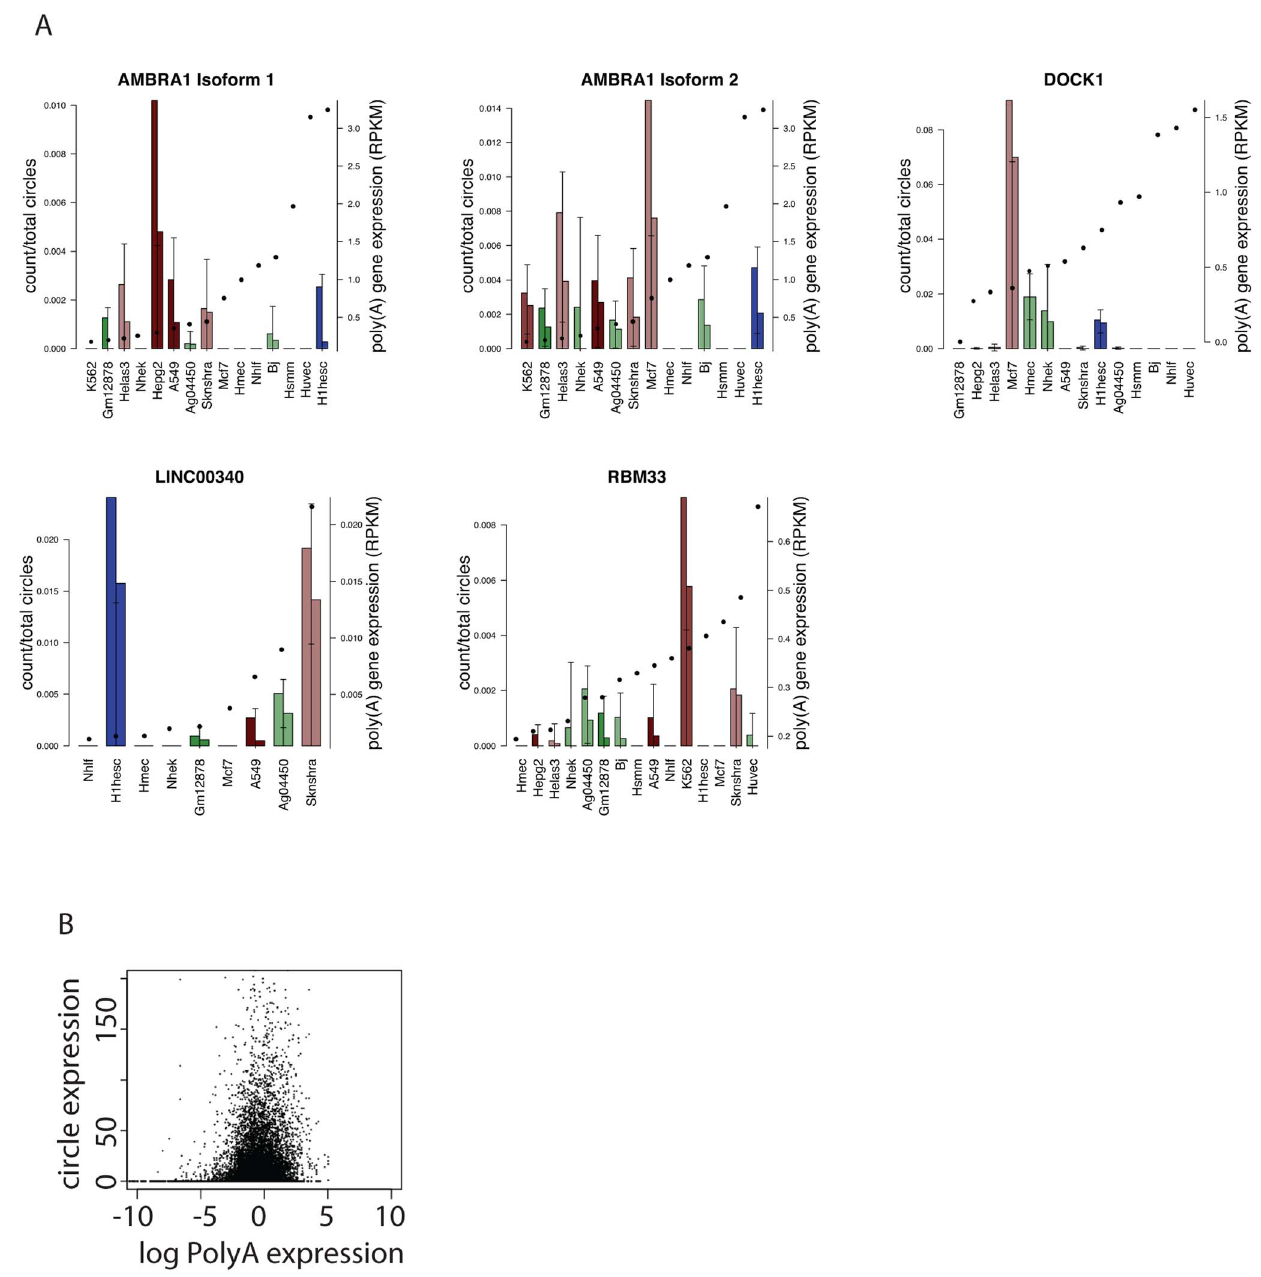
Figure 6. Quantitative regulation of circular to linear isoform ratios. A) Examples of circular RNAs with cell-type dependent expression as predicted by a genome-wide statistical model. Circular isoform abundance was estimated as a fraction of total circular RNA expression per replicate, and error bars represent statistical variation (3.5 sd of the mean); replicates are depicted separately. Two circular isoforms of AMBRA1 are shown. For each gene, cell types are ordered left to right by monotonic increasing expression of the linear isoform as measured by RPKM, with RPKM value overlaid as a solid dot. Bar plot colors are consistent across cell types: red representing cancer cell lines, blue H1-HESC and greens are non-cancers; shading from dark to light representing endoderm, mesoderm and ectoderm. B) Across cell lines, no genome-wide trend between circle expression and linear transcript expression as measured by log RPKM.